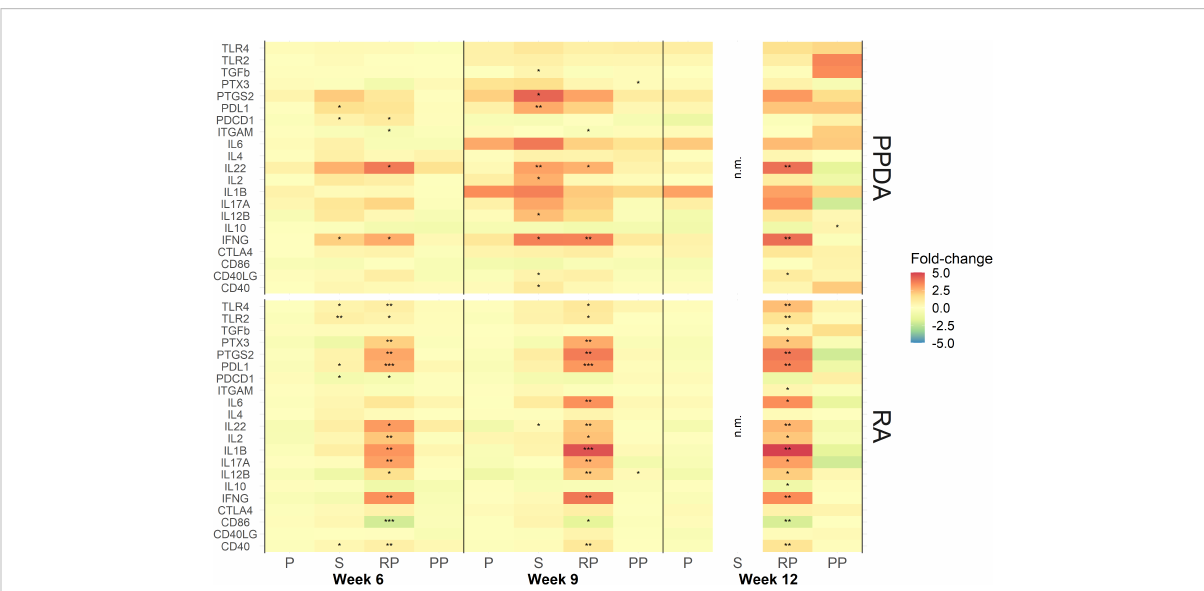
FIGURE 3 Expression of immune responsive genes in animal vaccinated with PBS (P), Silirum ® (S), recombinant MAP protein (RP), and MAP fusion protein particles (PP). Leukocytes were stimulated in vitro with either media alone, PPDA or RA at a fi nal concentration of 10 m g/mL for 24 h. Results are presented as ratios of fold-change (antigen stimulation/media alone) for each gene at weeks 6, 9 and 12 over expression at week 0. The data was log2 transformed for statistical analysis and statistical signi fi cance was calculated by comparing ratios of antigen stimulation/media alone of all the vaccine groups and week 0 expression of the PBS control group. Statistical signi fi cance was calculated compared with the PBS group (* = P < 0.05; ** = P < 0.01; *** = P < 0.001). Note: No responses were measured in Silirum ® -vaccinated animals at week 12 due to RNA being lost during sample